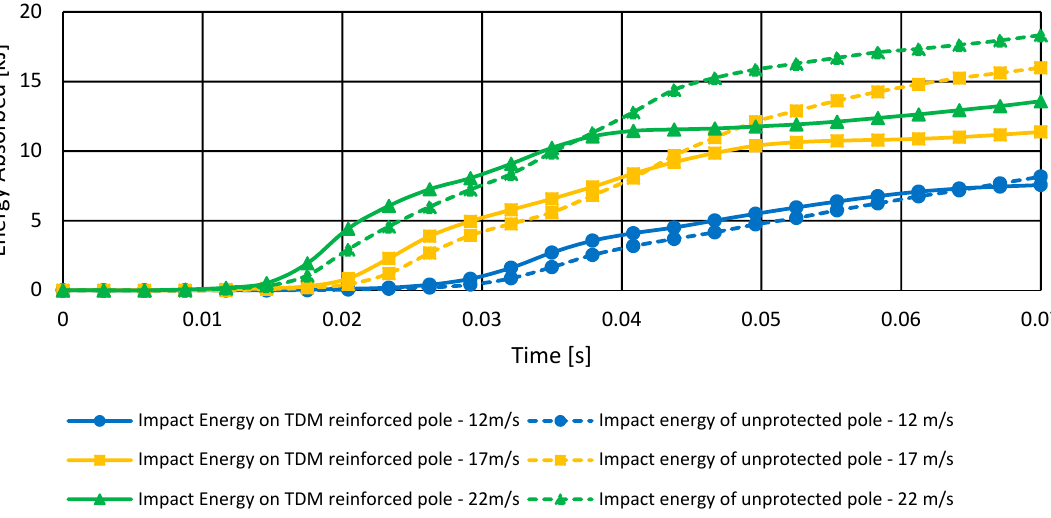
Figure 13. Impact energies absorbed by the vehicle on a street pole (using the corner collision method) with a TDM reinforcement of 35 mm using three different speeds at 12 ms − 1 , 17 ms − 1 and 22 ms − 1 .